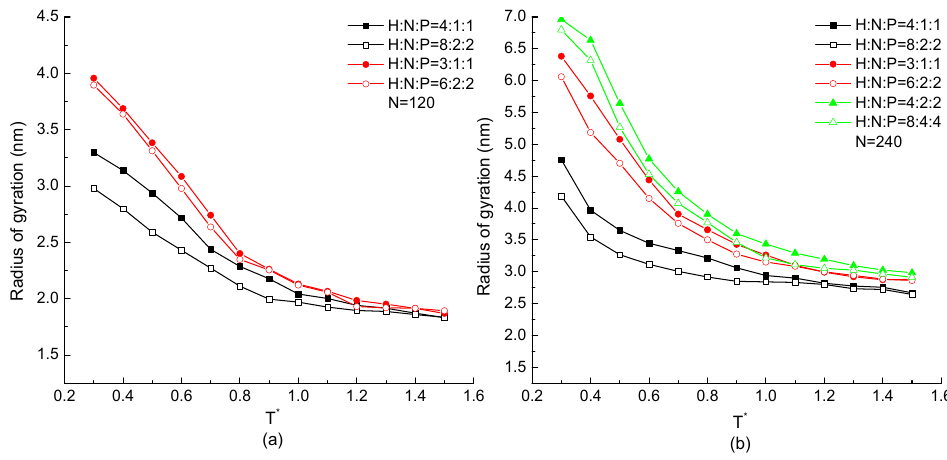
Figure 8. The radius of gyration versus reduced temperature T ∗ of different ratio and serial number of H, N, and P residues with protein chain length ( a ) N = 120, ( b ) N = 240 .